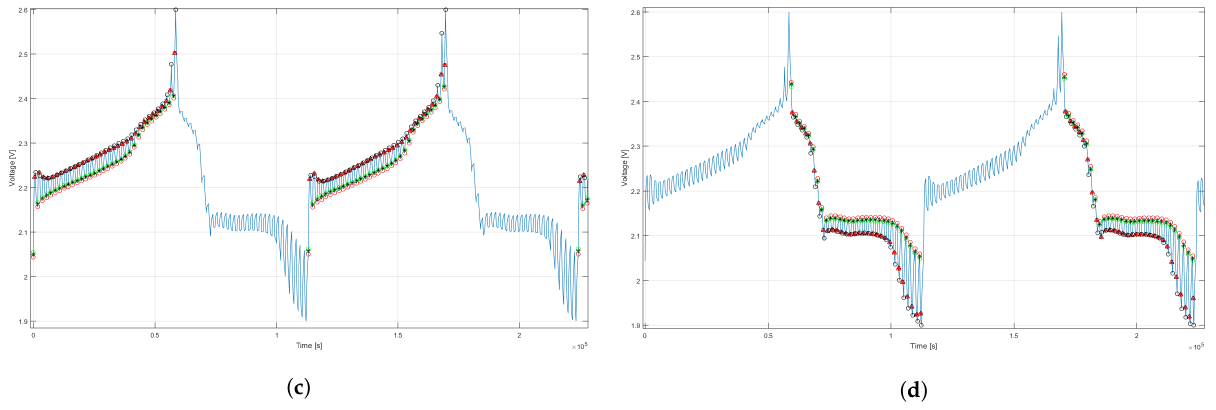
Figure 3. Pulse-based GITT methodology applied to the LiS battery for model parametrization during charge and discharge cycles. ( a ) GITT method applied to LiS battery. ( b ) GITT-based parametrization analysis. ( c ) GITT method applied during charge. ( d ) GITT method applied during discharge .